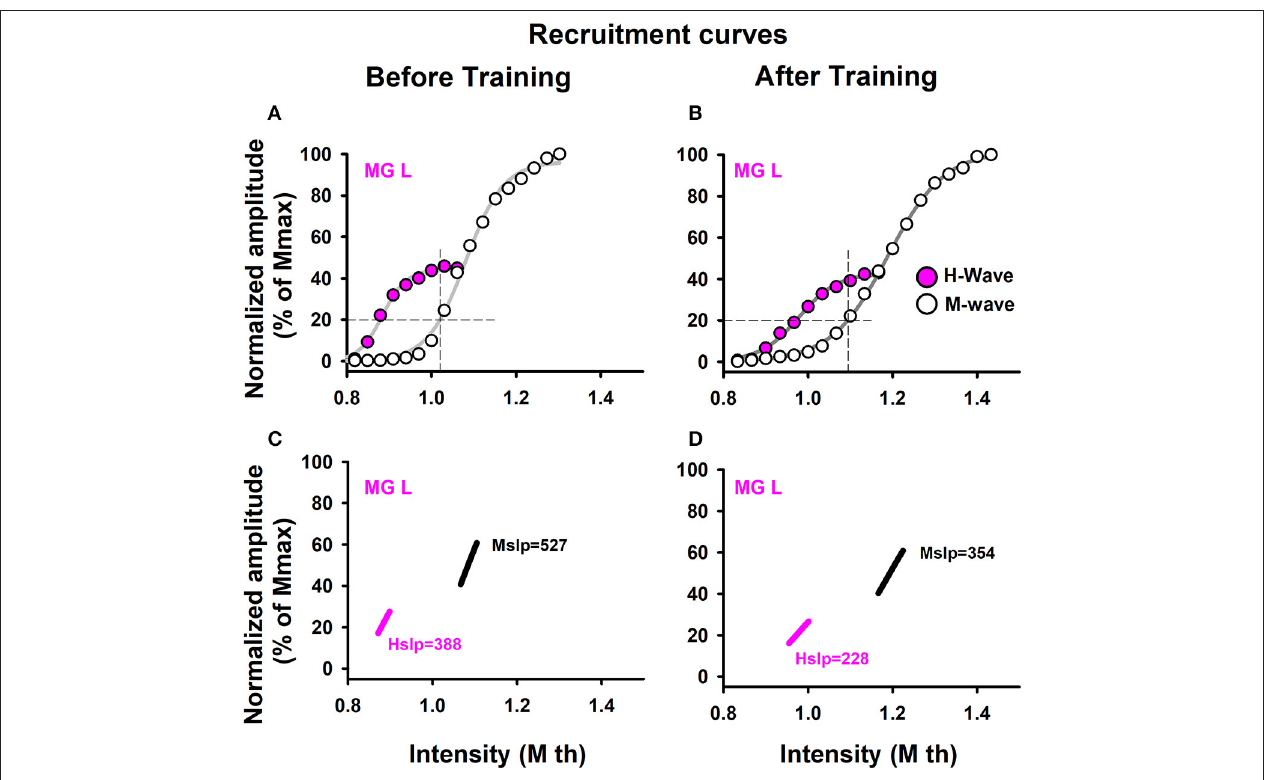
FIGURE 2 | Recruitment curves. Data were obtained from one representative sedentary subject. Recruitment curves for the M-wave and H-wave: (A) before training and (B) after training. (C,D) Slopes for the M-wave and H-wave curves illustrated in (A,B)